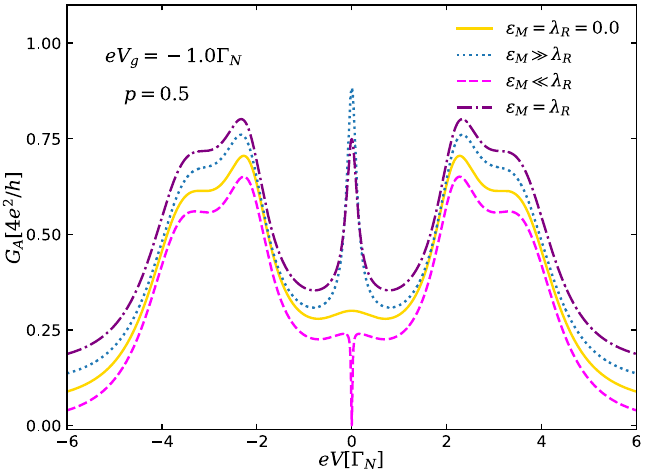
0.5 ), = (cid:31) 0 ), while teal R = = (cid:31) R ) ≫